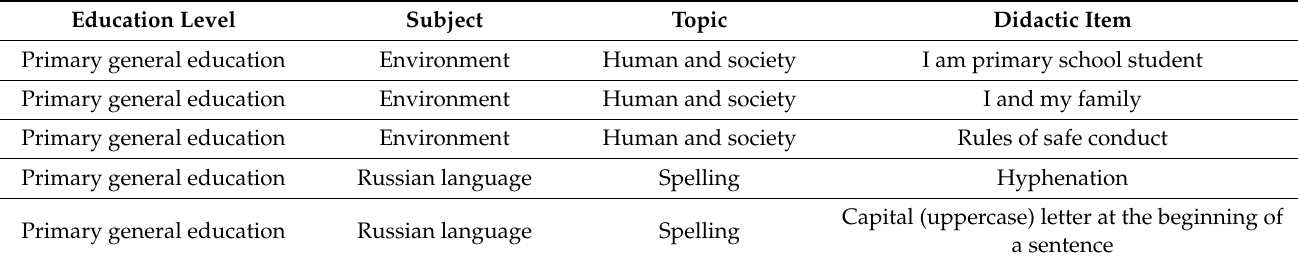
Table 2. Example of the data interconnected in the topical framework in the